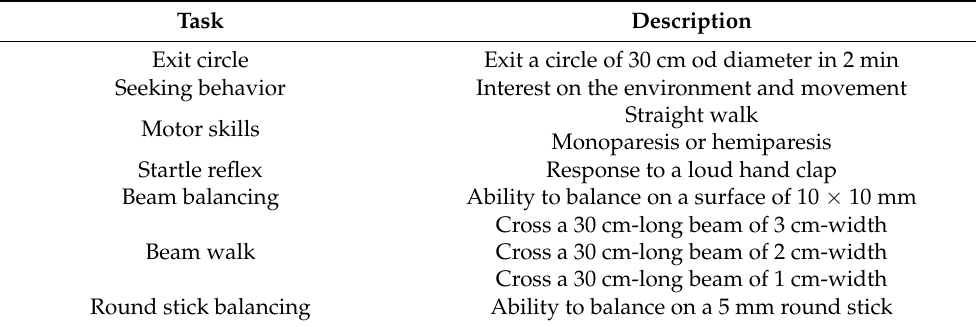
Table 1. Neurological Severity Score